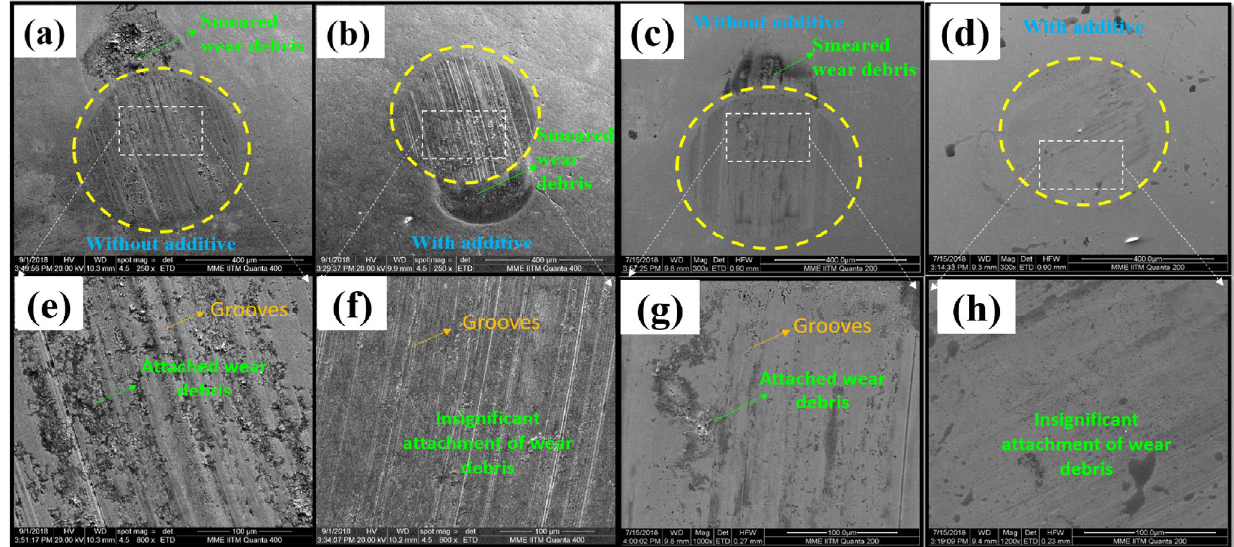
Fig. 9 SEM micrograph of worn surfaces at 29  C: (a, e) base oil, (b, f) 0.00625 mg/ml nano-oil, and worn surfaces at 75  C: (c, g) base oil, (d, h) 0.00625 mg/ml